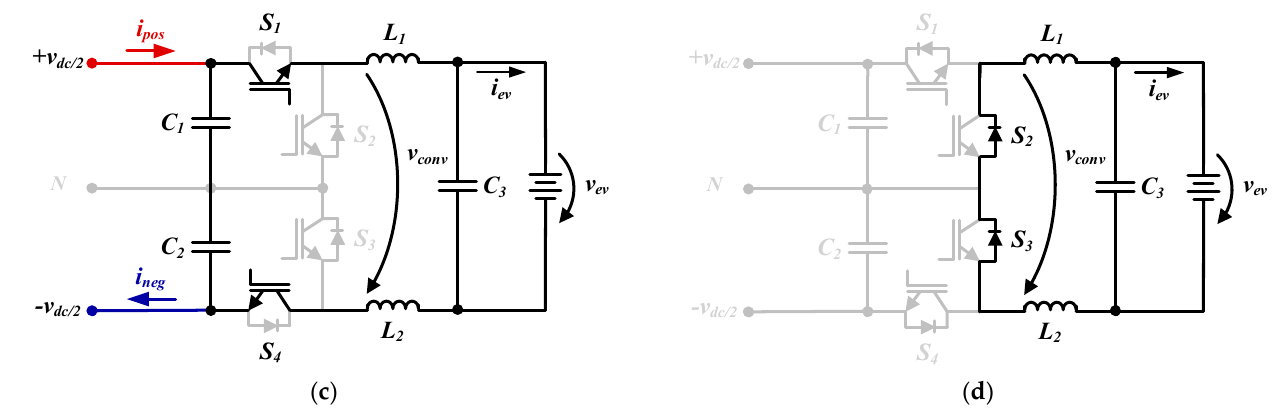
Figure 5. Operation principle of the multilevel dc–dc converter under fault conditions connected to a bipolar dc grid: ( a ) failure in the positive wire of the bipolar dc grid; ( b ) failure in the negative wire of the bipolar dc grid; ( c ) failure in the neutral wire of the bipolar dc grid; ( d ) common operation mode to the mentioned three failures.